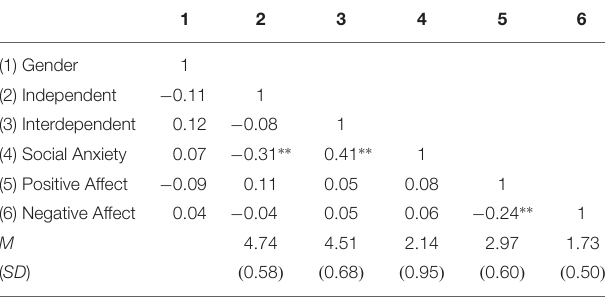
TABLE 1 | Zero order correlations and descriptive statistics of study main